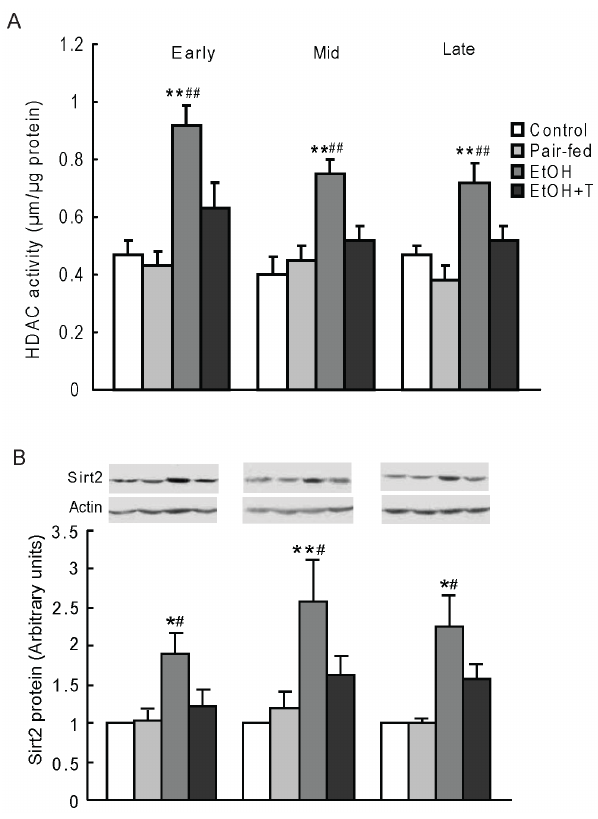
Figure 4. Hepatic HDAC activity (A) and nuclear SIRT2 protein level (B) in 4 month-old male rat offspring exposed to ethanol (EtOH) or water only during early, mid, or late pregnancy. Control and pair-fed offspring were from dams with free access to chow and dams fed the amount of chow consumed by EtOH dams, respectively. A subgroup of EtOH rats was given TUDCA (T) 3 weeks before the experiments. Data are the mean 6 SE, n=6. *P , 0.05, **P , 0.01 EtOH vs. control; # P , 0.05, ## P , 0.01 EtOH vs. pair-fed.